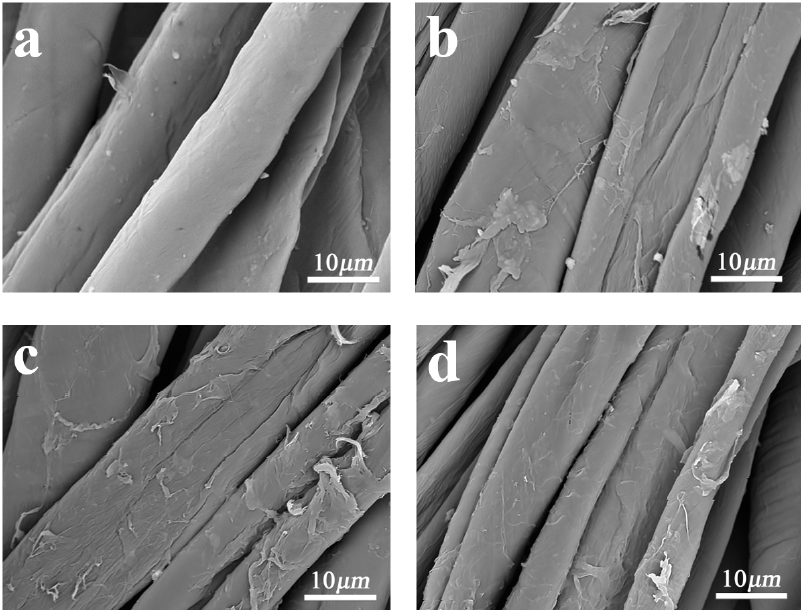
Figure 4. SEM images of ( a ) control cotton fabric; ( b ) TLP-modified cotton fabric; ( c ) DMP-modified cotton fabric; ( d ) ADP-modified cotton fabric. The embedded SEM image in the upper right corner of each photo was the surface morphology of corresponding fabric at a higher magnification.